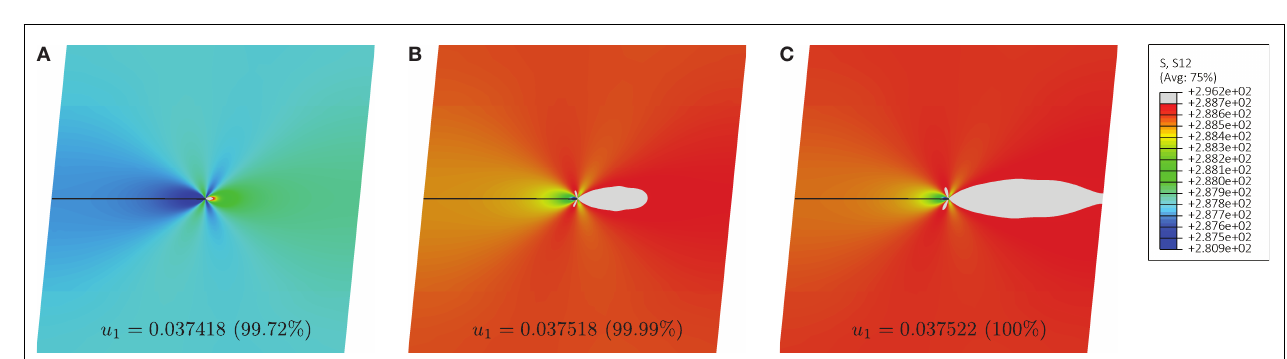
FIGURE 5 |The three meshes used in the analysis to simulate a shear band (highlighted in black) in a square solid block ( L = H = 10mm) .The shear band is represented in the three cases as an interface with the same constitutive thickness h = 0.005mm, but with